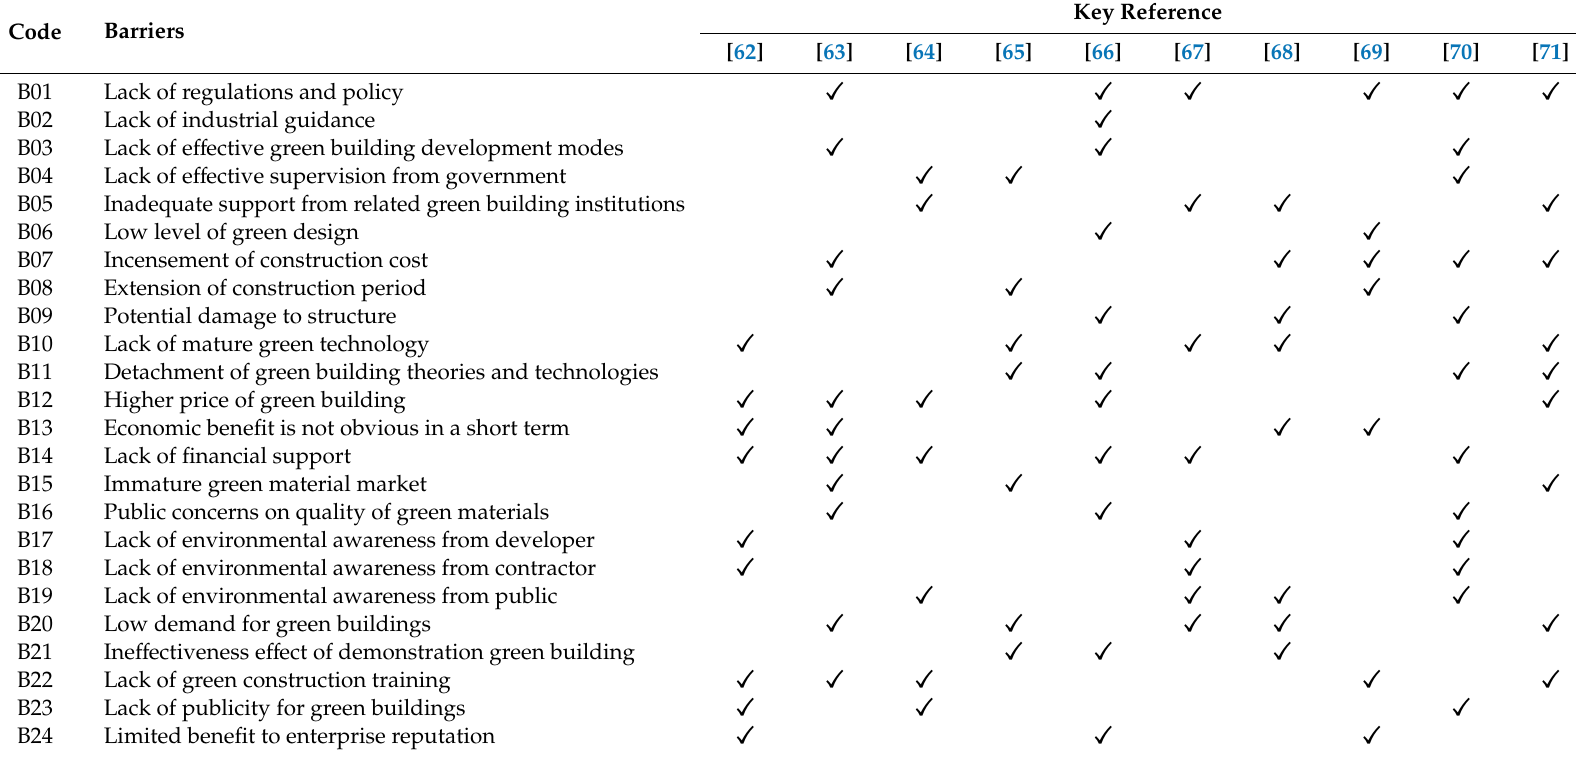
Table 1. Potential barriers of green building